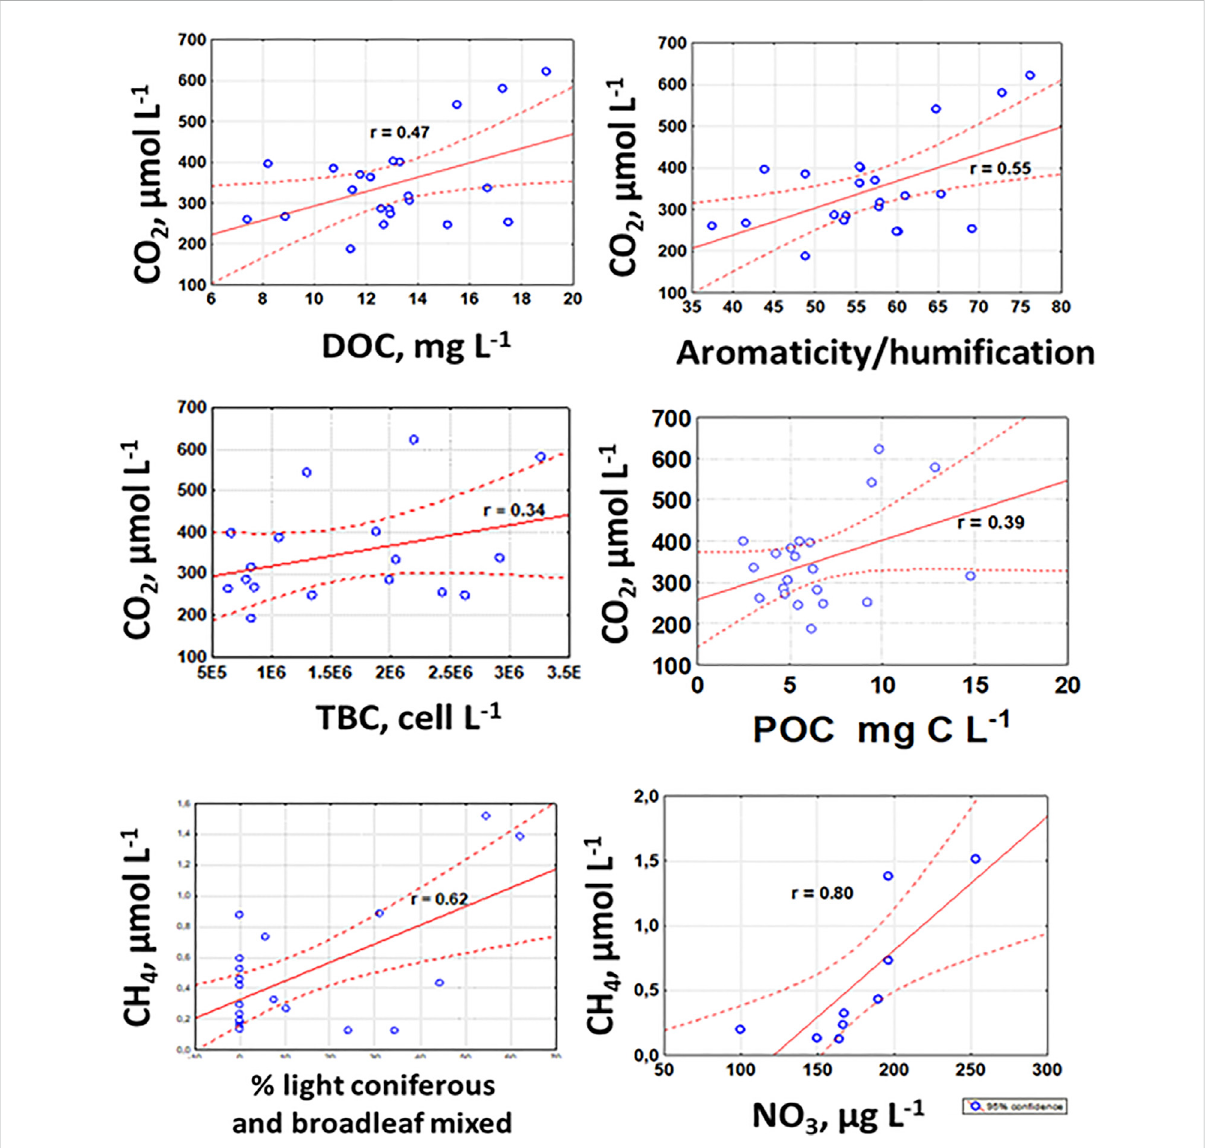
FIGURE 4 Signi fi cant ( p < 0.05) positive control of river water hydrochemical parameters (DOC, POC, Aromaticity, nutrients), bacterial number (TBC) and land cover parameters (forest) on CO 2 and CH 4 concentrations in the Taz River main stem and